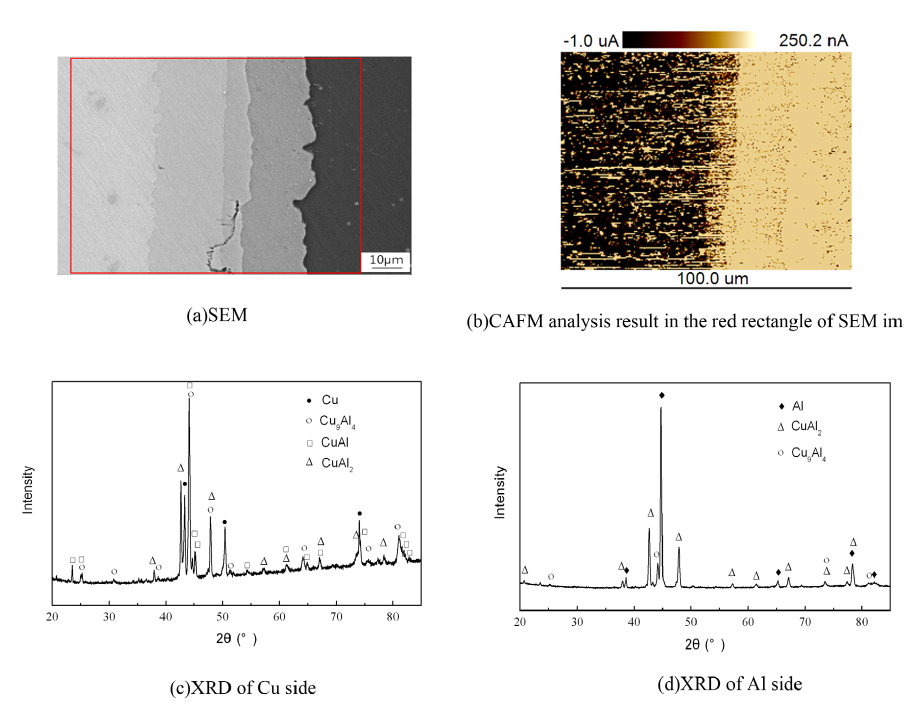
Figure 6. SEM, CAFM and XRD results of diffusion brazed Cu/Al joint after heat treatment at 350°C for 500h: (a) SEM; (b) CAFM analysis result in the red rectangle of SEM image; (c) XRD of Cu side; (d) XRD of Al side.